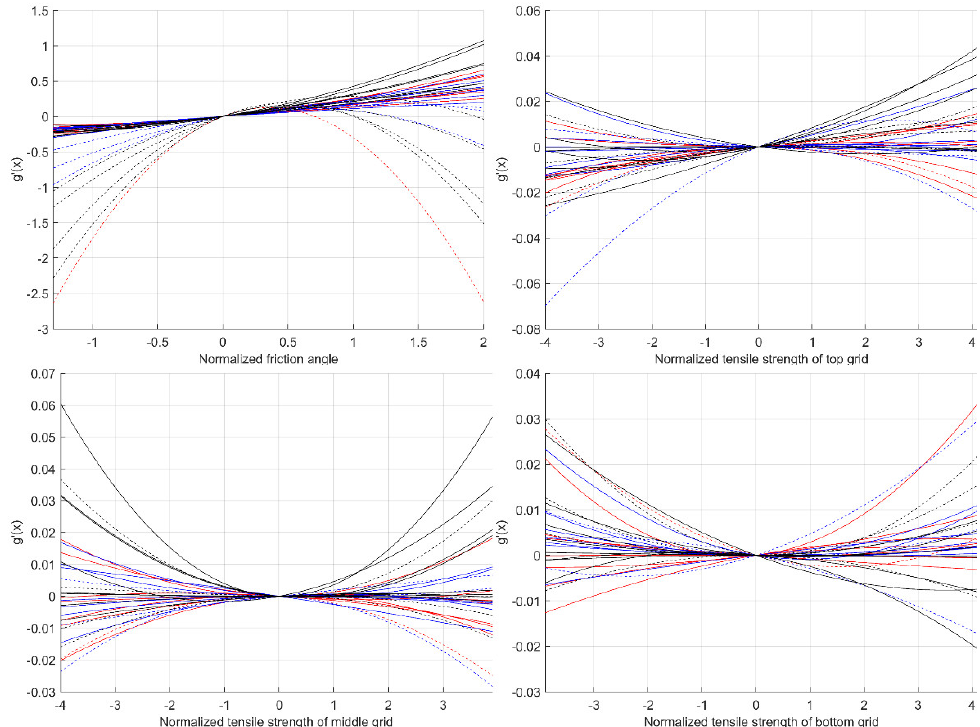
Figure 12. Trends of the response surface around the design point for LSF10 for low (red lines), mean (blue lines) and high interface friction angle (black lines), with full lines representing response for shallow sliding, and dashed lines for deep sliding.